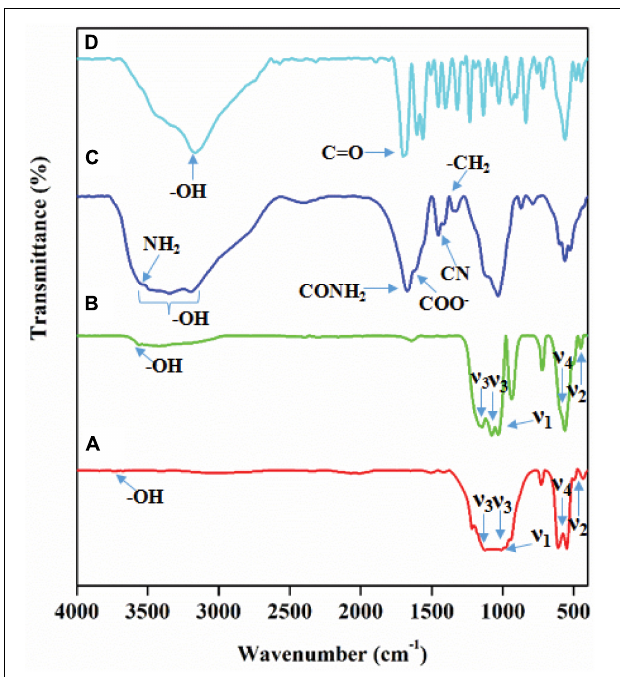
FIGURE 1 | FT-IR spectrum of (A) HA, (B) BM-HA, (C) BM-HA/PAA, and (D) BM-HA/PAA/UMB